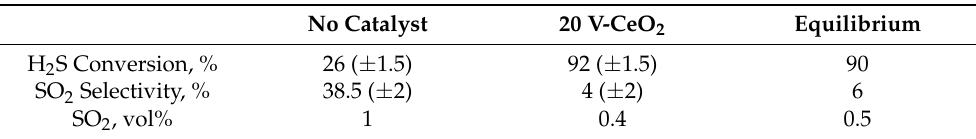
Table 1. Comparison between non-catalytic system, catalytic system, and equilibrium (T = 327 °C, H 2 S = 10 vol%).